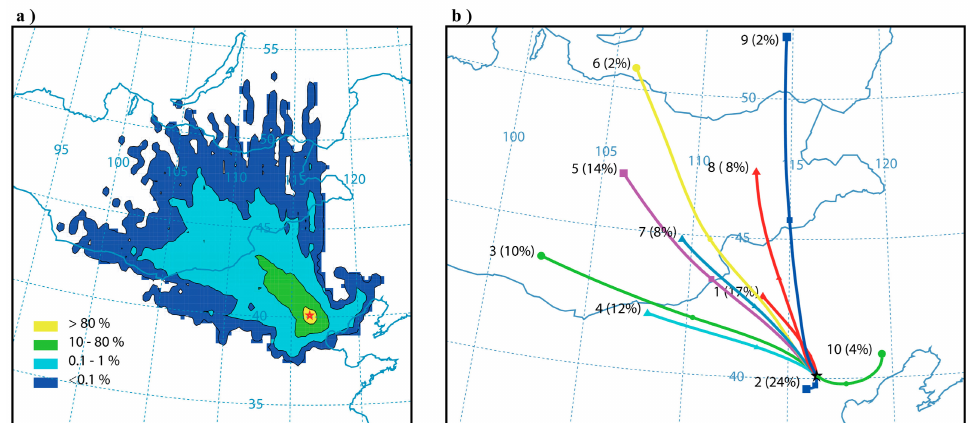
Figure 4. The spatial distribution of the trajectory frequency ( a ), and cluster-mean results of 24-h backward trajectories ( b ) calculated by the Hybrid Single-Particle Lagrangian Integrated Trajectory Model (HYSPLIT) ending at Beijing (116.37 ◦ E; 40.09 ◦ N, pentagram) at 100 m height AGL during winter from December 2018 to February 2019. The dots on the trajectories represent time node of 12h, and the percentage represents the ratio of the number of back trajectories in each cluster to the total number of back